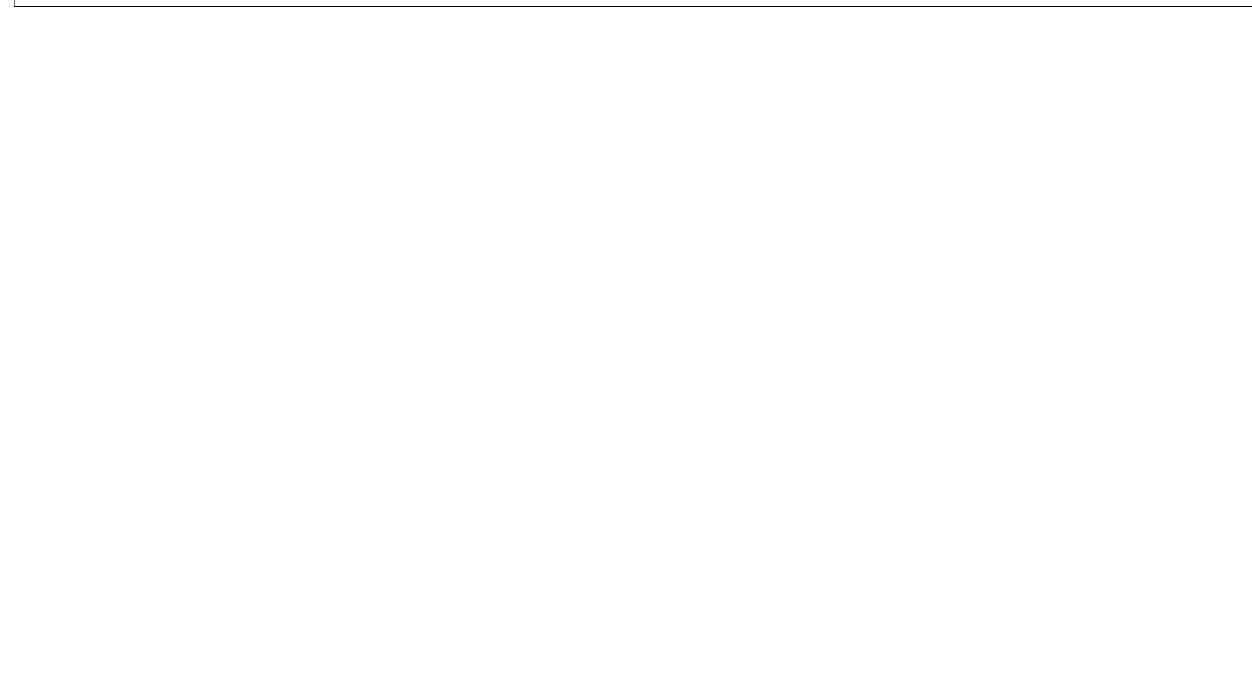
Frontiers in Pharmacology |